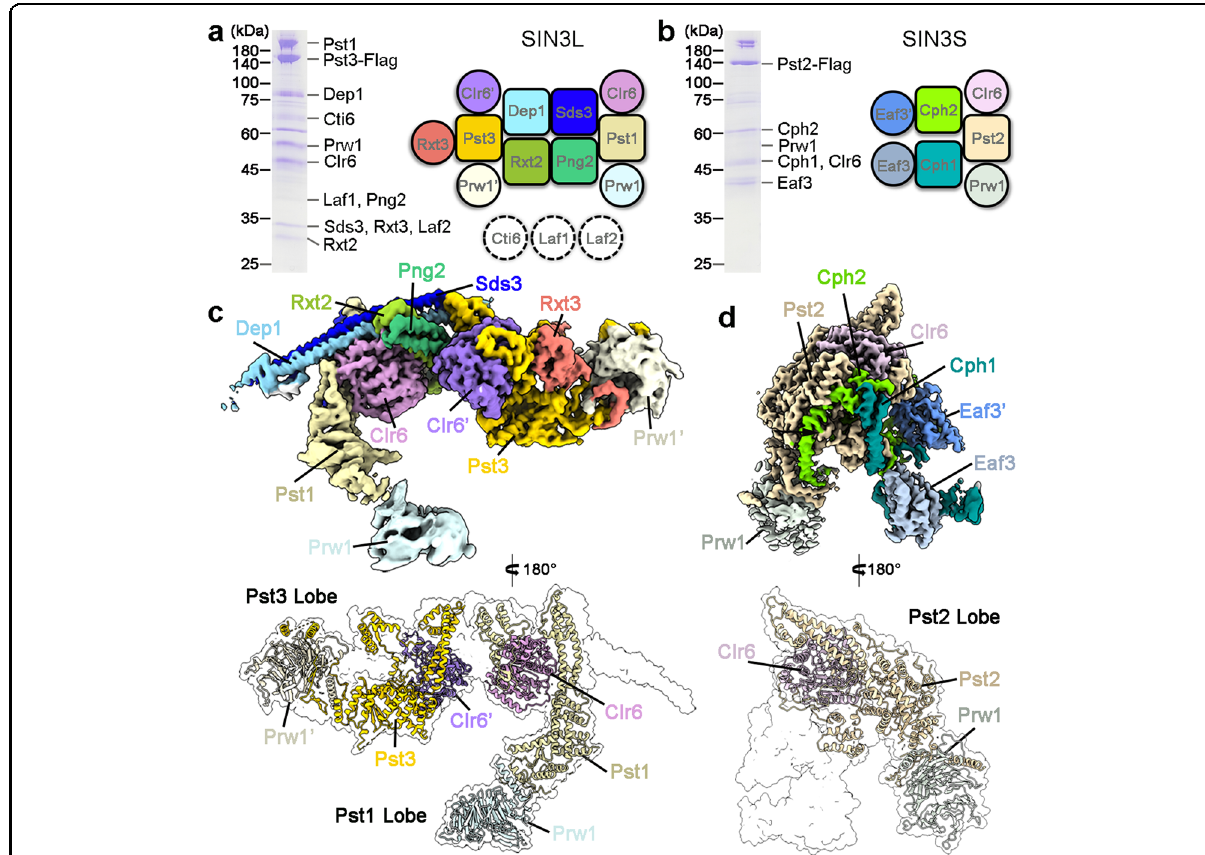
Fig. 1 Structure determination of the SIN3L and SIN3S complexes from S. pombe . a Puri fi cation and schematic view of the SIN3L complex. The components of SIN3L were separated on 12% SDS-PAGE and further con fi rmed by mass spectrometry analysis. The schematic diagram shows the subunit organization of the SIN3L complex. Three components (Cti6, Laf1, and Laf2), present in a puri fi ed sample, are labeled in dotted circles for not included in the fi nal model. b Puri fi cation and schematic of the SIN3S complex. The components of SIN3S were separated on 12% SDS-PAGE and further con fi rmed by mass spectrometry analysis. The schematic diagram shows the subunit organization of the SIN3S complex. c Overall structure of the SIN3L complex. The 3.2-Å EM map is shown in the upper panel with individual component color-coded identically. In the lower panel, the Pst1 Lobe (containing Pst1, Clr6, and Prw1) and the Pst3 Lobe (containing Pst3, Clr6 ’ , and Prw1 ’ ) are present as a colored cartoon with the whole complex in transparent surface. d Overall structure of the SIN3S complex. The 2.9-Å EM map is shown in the upper panel with individual component color- coded identically. In the lower panel, the Pst2 Lobe (containing Pst2, Clr6, and Prw1) is present as a colored cartoon with the whole complex in transparent surface. All structural images in this paper were generated in ChimeraX 64 and PyMOL 65